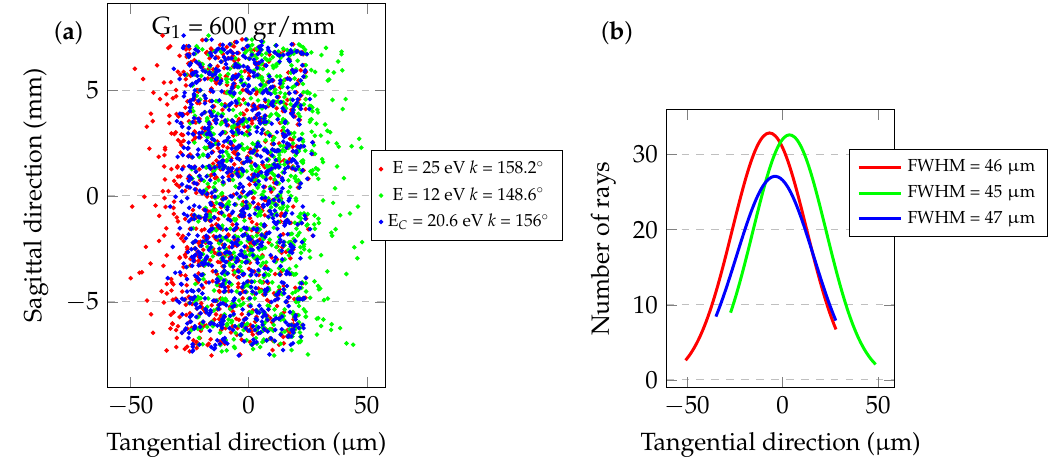
Figure 6. Ray-tracing results of the entrance slit projected to the output for the values given in Table 1 (G 1 grating). ( a ) Image shape for three different energies and ( b ) width in the tangential